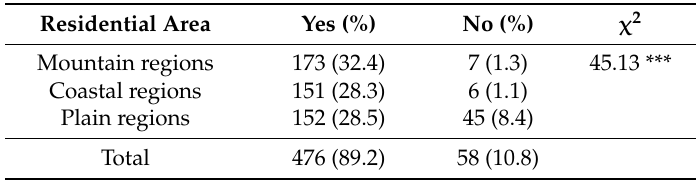
Table 7. Participants received tobacco hazards prevention education (n =